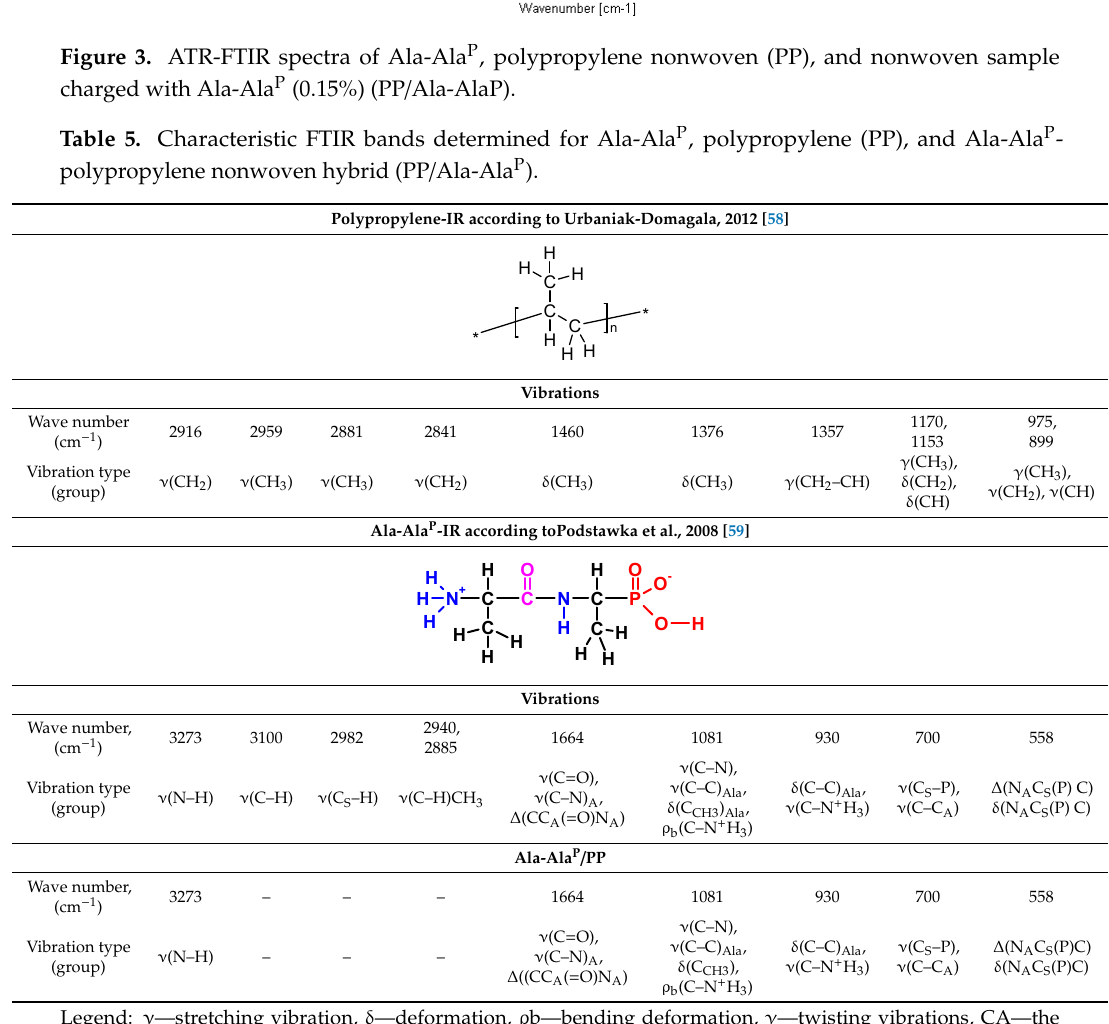
Figure 3. ATR-FTIR spectra of Ala-Ala P , polypropylene nonwoven (PP), and nonwoven sample charged with Ala-Ala P (0.15%) (PP/Ala-AlaP).